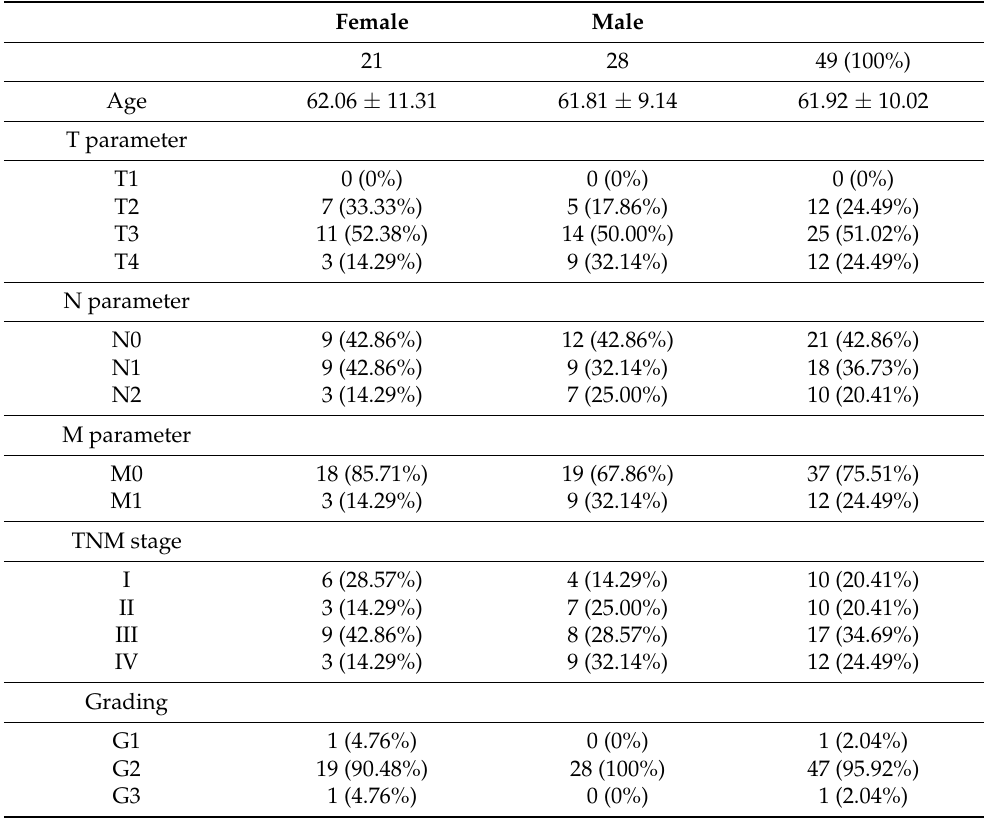
Table 1. Characteristics of the